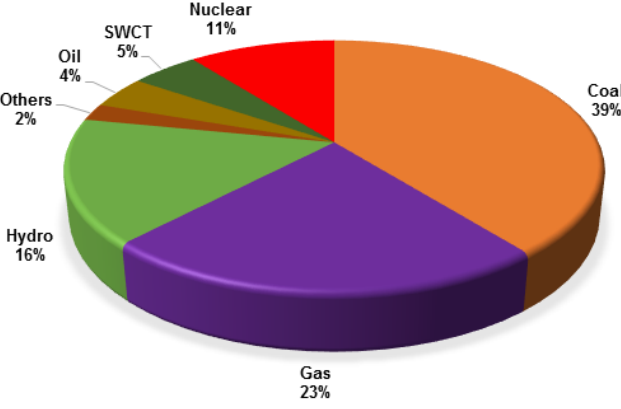
Figure 3. Worldwide energy source distribution (Total of 24,345 TWh). Adapted from [12].